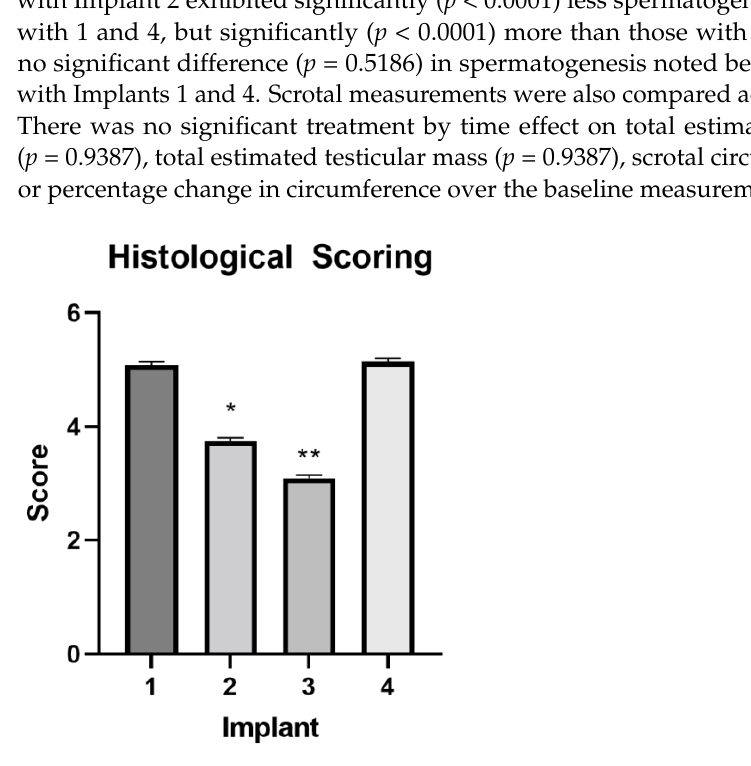
Figure 1. Differences in the extent of spermatogenesis among treatment groups in Pilot 1. Scores not connected by asterisks (* or **) are significantly different ( p < 0.05).